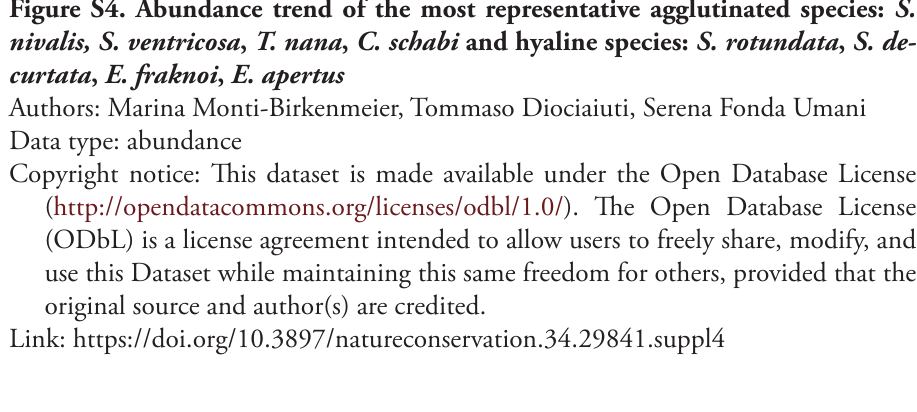
Figure S4. Abundance trend of the most representative agglutinated species: S.